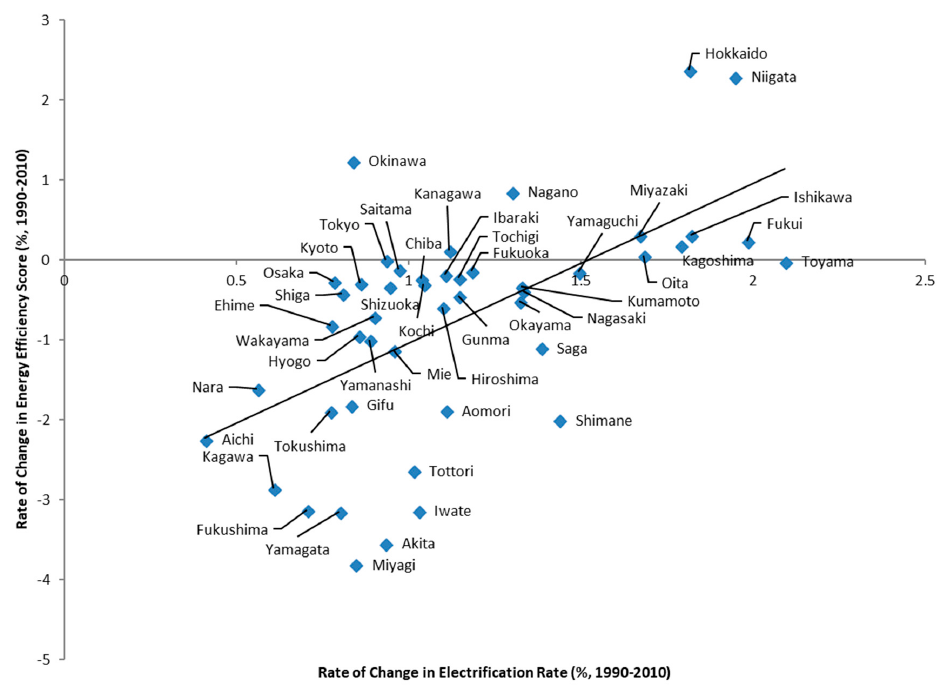
Figure 3. Dynamic relationship between energy efficiency score and electrification rate.